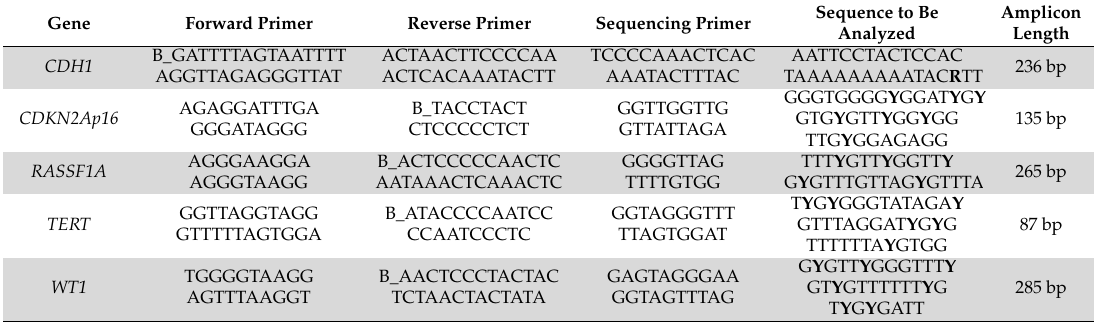
Table 6. Primer Sets 5 (cid:48) -3 (cid:48) and the amplicon length of the sequencing assays; B—biotin, R = A or G (indicates a CGs in reverse assays); Y = C or T (indicates CGs).